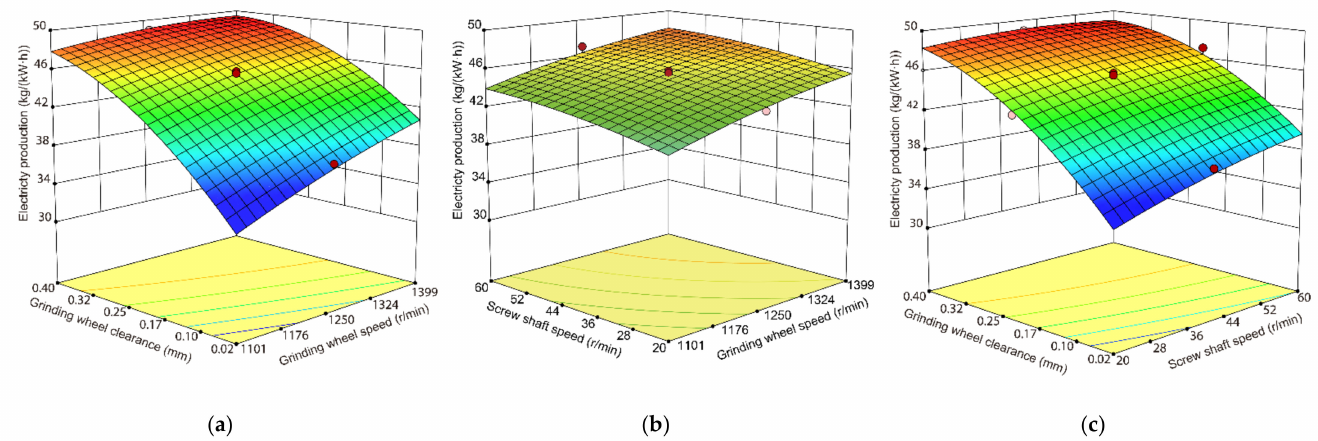
Figure 8. Response surface analysis of the experimental factors on electricity production. ( a ) Effects of grinding wheel clearance and speed on the electricity production. ( b ) Effects of screw shaft speed and grinding wheel speed on the electricity production. ( c ) Effects of grinding wheel clearance and screw shaft speed on the electricity